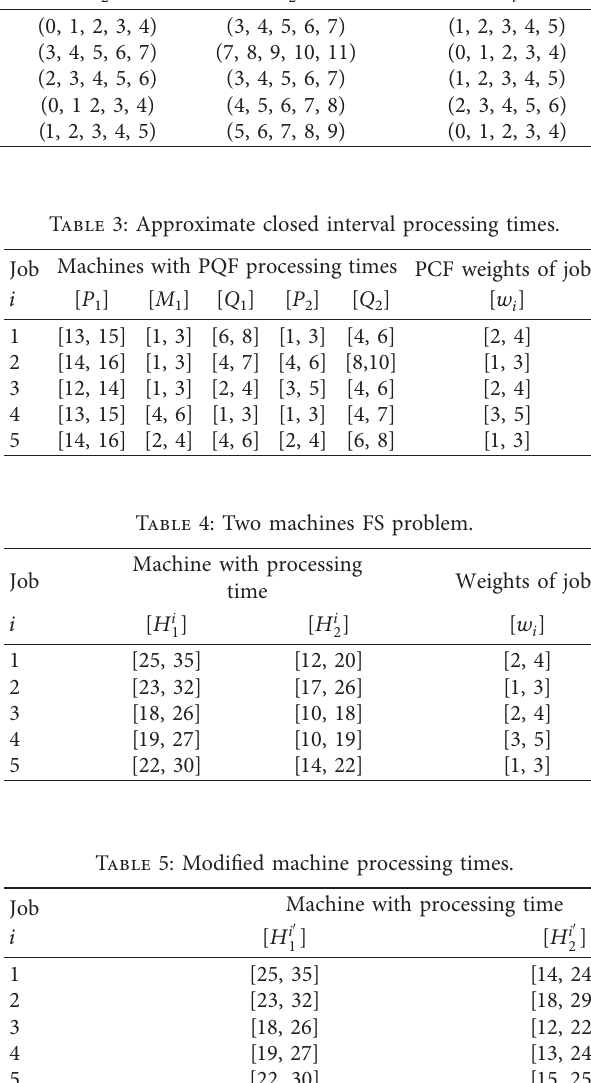
Table 2: Piecewise quadratic fuzzy processing times 􏽥 M